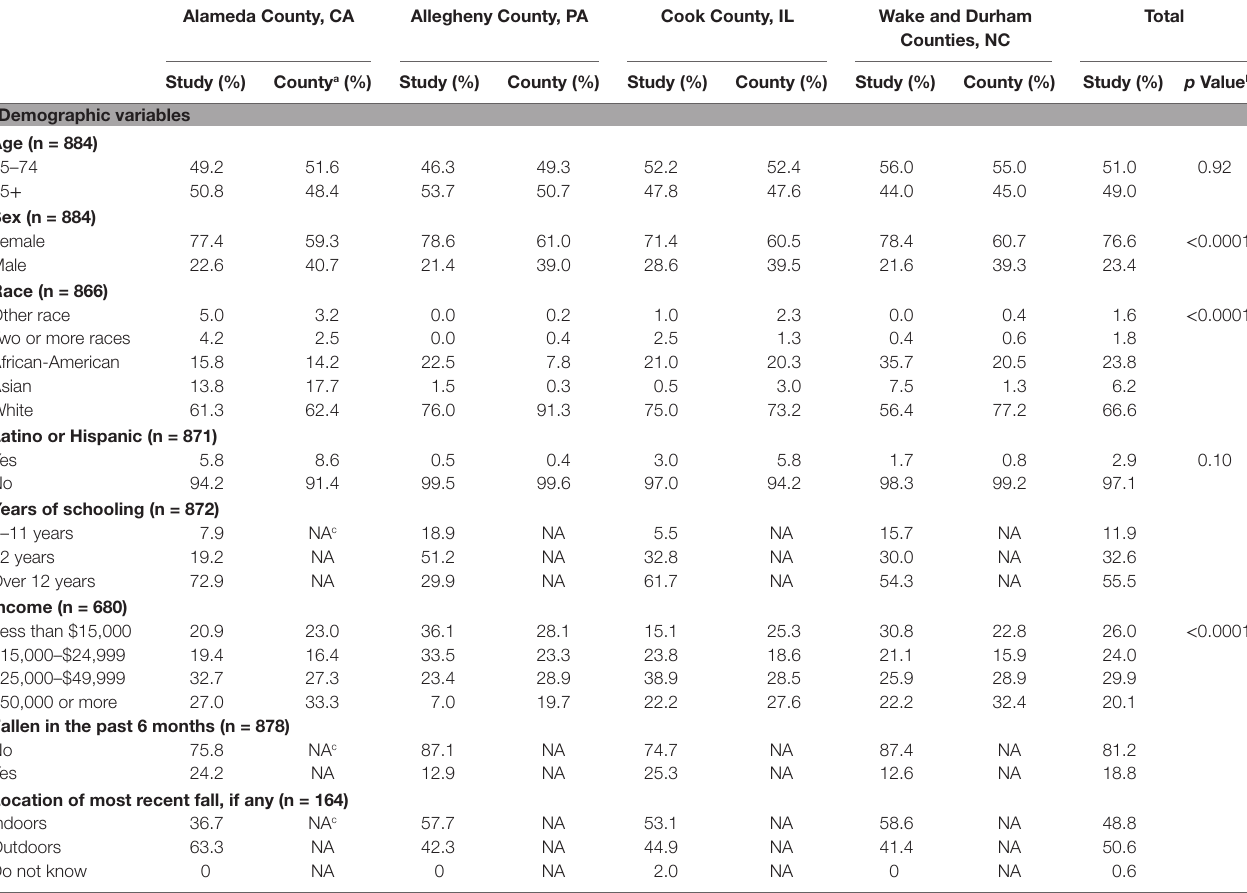
TaBle 1 | Demographics and falls by site compared to county census